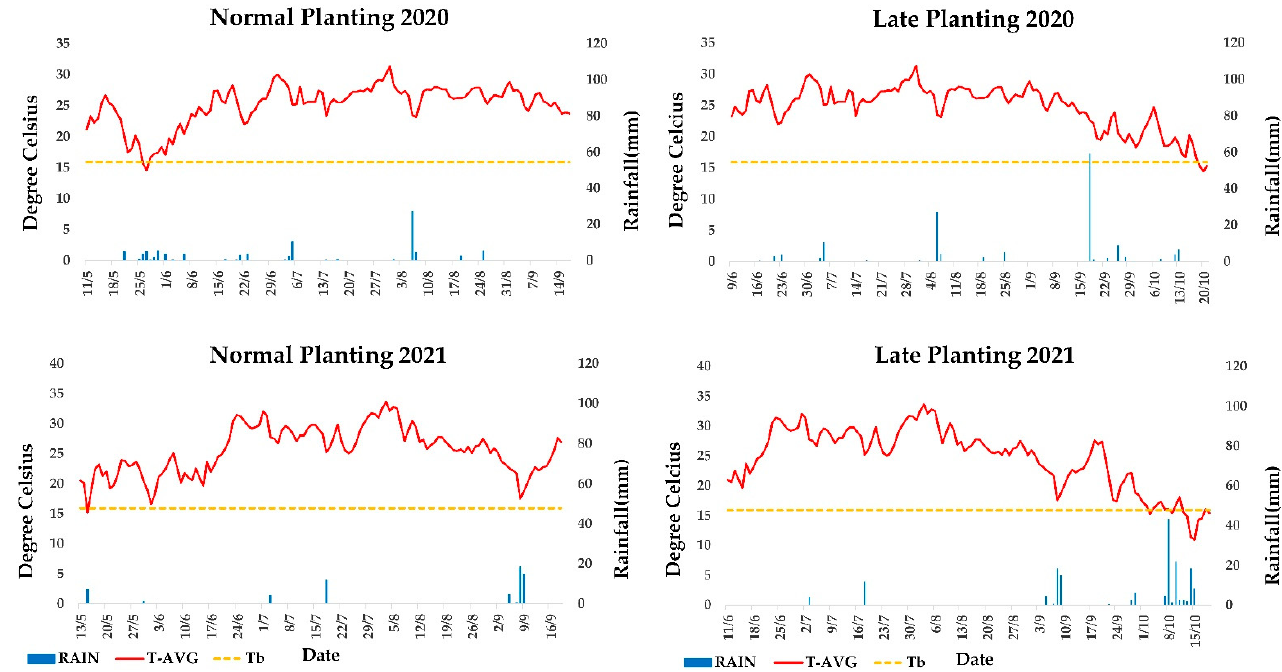
Figure 3. Climate data across growing conditions and years (NP20, LP20, NP21, LP21). Daily Precipitation (RAIN), daily average air temperature (T-AVG), base temperature for sesame (Tb).